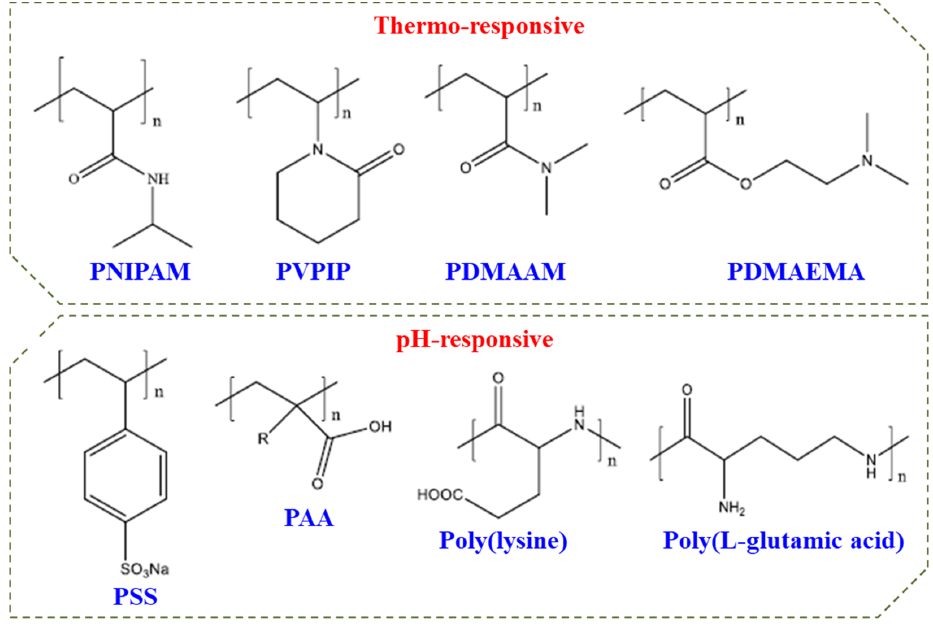
Figure 9. Commonly used polymers in DHBCs.